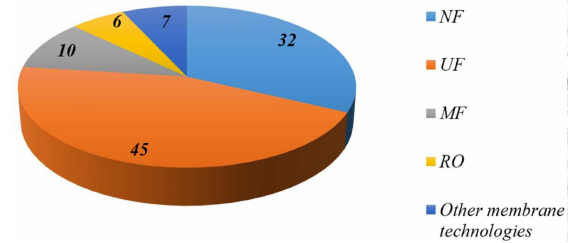
Figure 1. Overview about the use of nanocomposite membranes in pressure-driven membrane technologies for water treatment (data acquired from https://www.scopus.com and https://scholar.